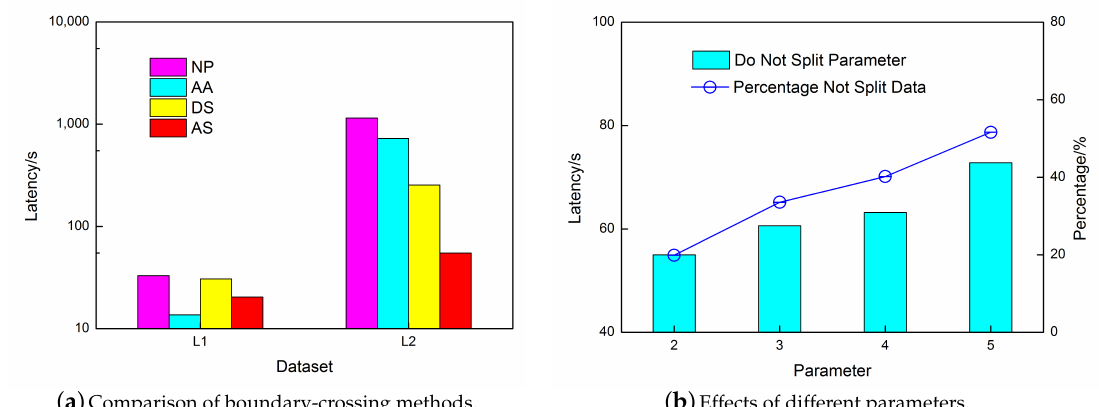
Figure 9. Experiment on cross-grid data processing methods.